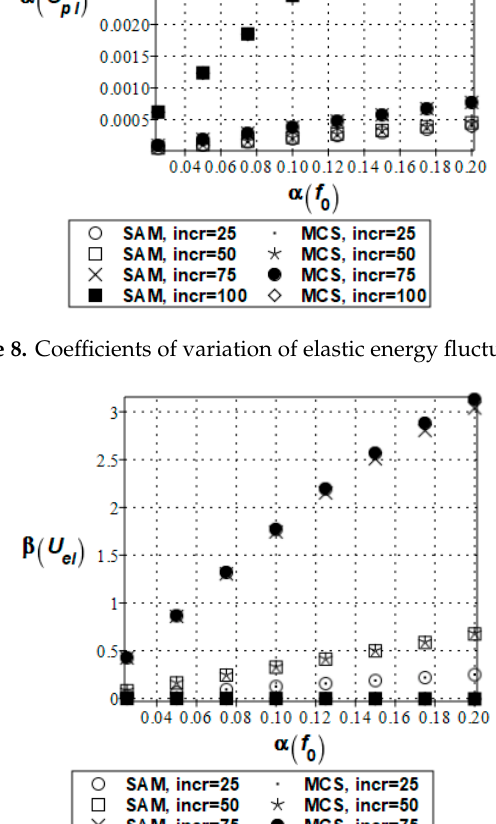
Figure 9. Skewness of elastic energy fluctuations.